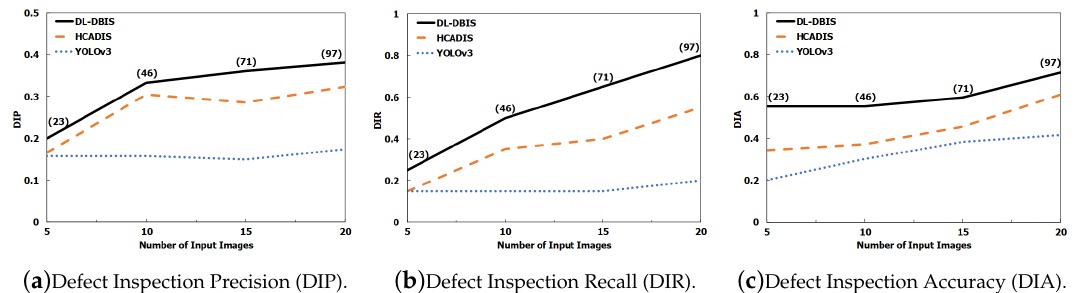
( a ) Defect Inspection Precision (DIP). ( b ) Defect Inspection Recall (DIR). ( c ) Defect Inspection Accuracy (DIA). Figure 17. Performance comparisons of different defect inspection schemes to various number of inputted bean images.